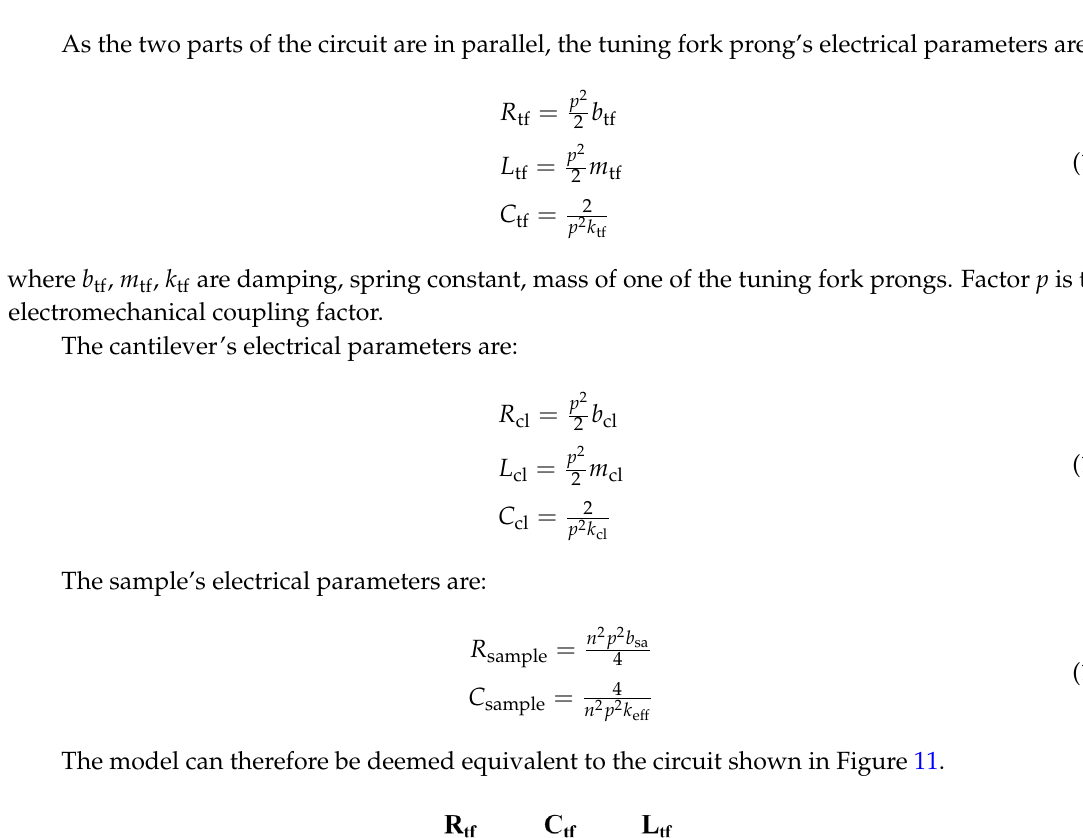
Figure 10. The transformation from mechanical parameters to electrical parameters.